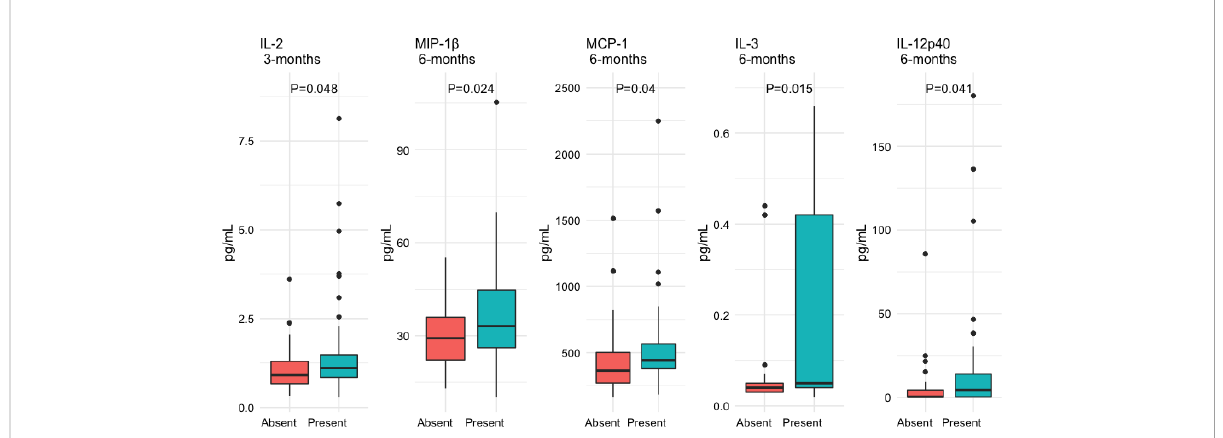
FIGURE 3 Differential expression of serum cytokine and chemokines 3 and 6 months after recruitment of patients with COVID-19 according to the presence of a sustained immune humoral response. The serum levels of the cytokines and chemokines are expressed as medians and interquartile ranges and were compared with the Wilcoxon